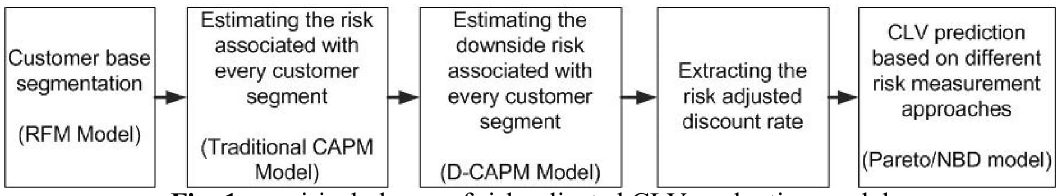
Fig. 1. empirical phases of risk-adjusted CLV evaluation